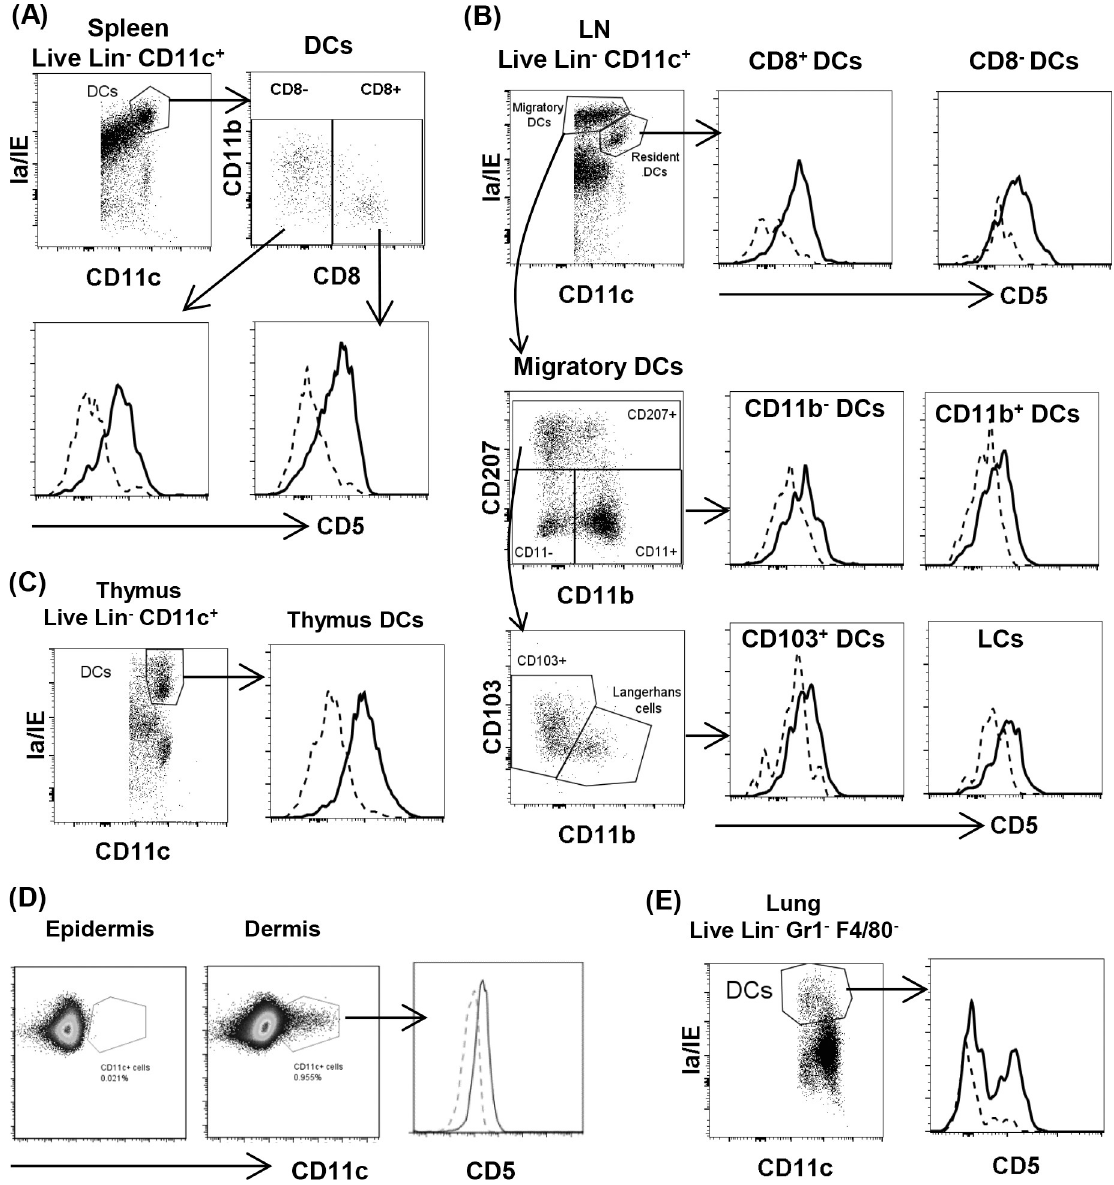
Fig 1. Expression of CD5 on dendritic cells. DC from various lymphoid and non-lymphoid organs are analyzed. In histograms, CD5 staining (solid line) is compared to fluorescence minus one (FMO) control (dashed line). (A) Gated SP DC (Lin-/CD11c+/Ia-IE+) express CD5. Both CD8 α + and CD8 α - subsets express a similar level of CD5. (B) Resident and migratory DC from LN are gated and analyzed. CD8 α + and CD8 α - resident DC express a higher level of CD5 than migratory DC which include four subpopulations (CD11b+, CD11b-, CD103+ and Langerhans CD207+/CD103-). (C) Gated thymus DC (Lin-/CD11c+/Ia-IE+) express CD5. (D) Dermal CD11c+ DC express CD5. Only few CD11c+ cells from the epidermal cells can be detected. (E) DC from the lung (Lin-/Gr1-/F4/80-/CD11c+/Ia/IE+) express CD5. The data are representative of 2–3 independent